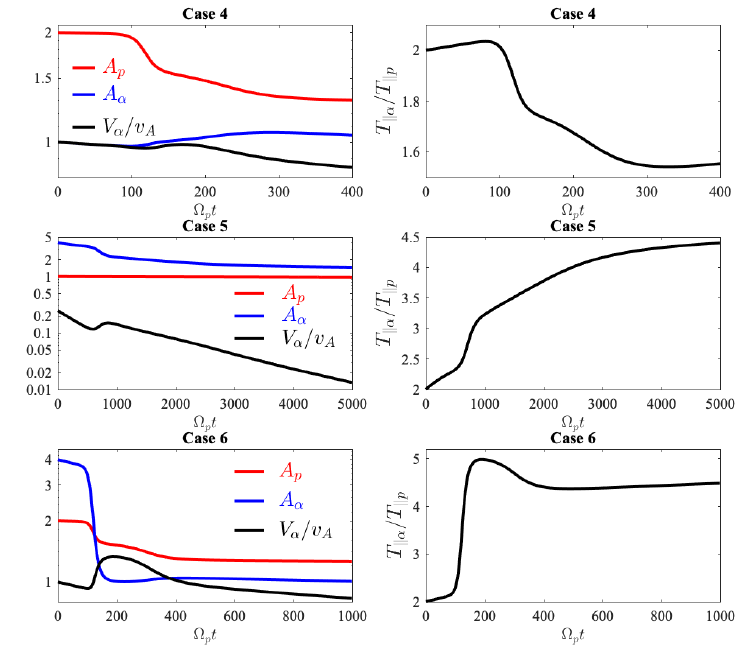
Figure 4. The relaxation of the drift velocity and the induced temperature anisotropies ( left column ), and alpha-proton temperature ratio ( right column ) for cases 5 and